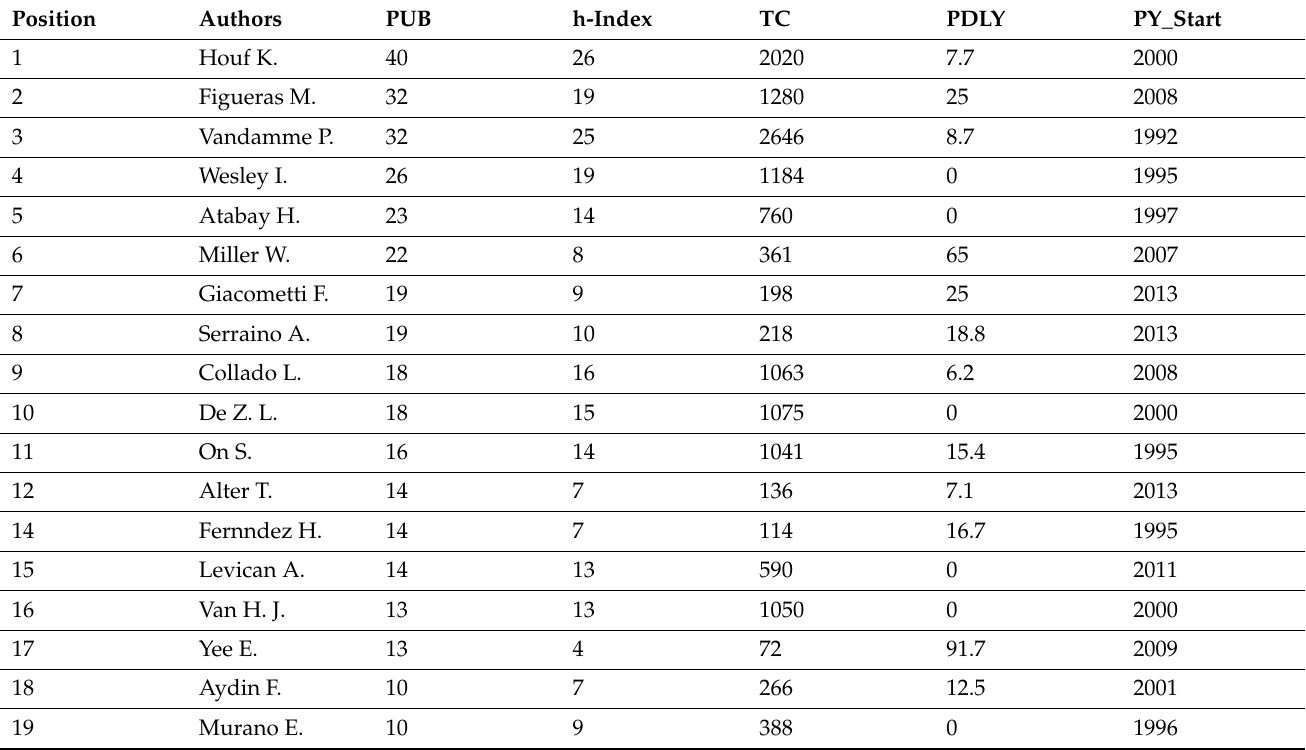
Table 3. Most productive authors in Arcobacter research.